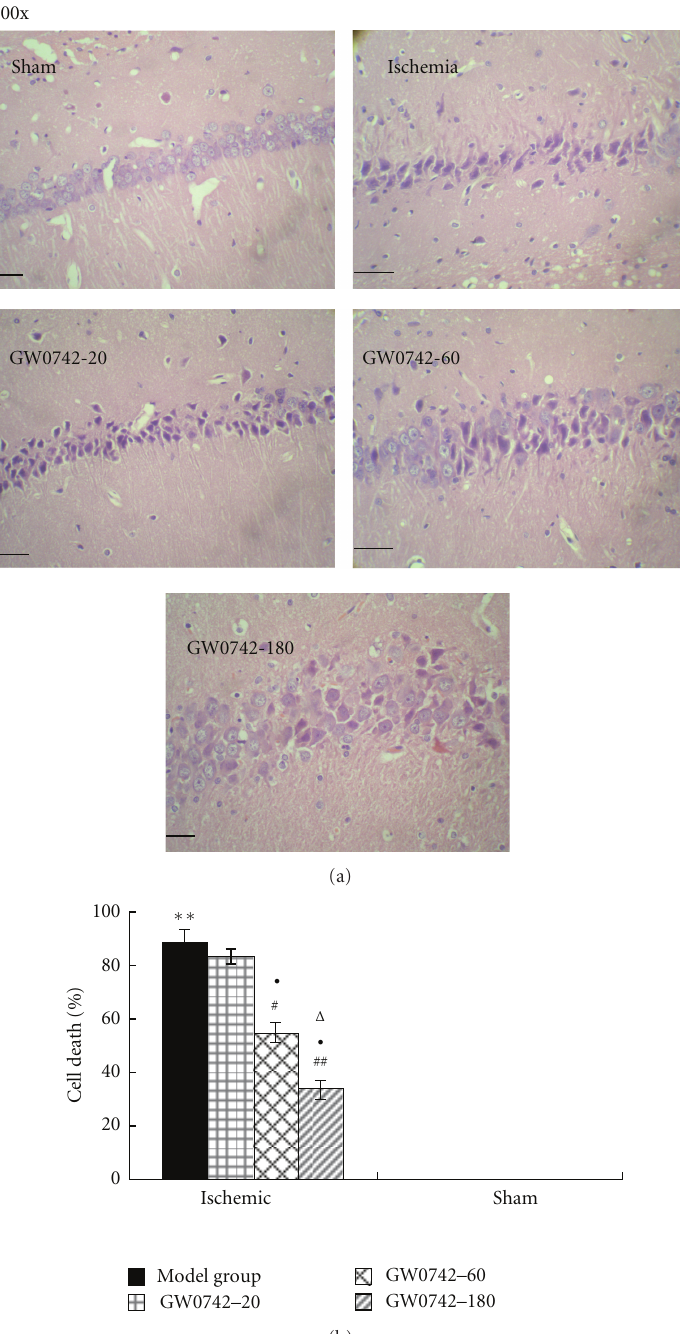
Figure 1: PPAR- β agonist GW0742 improves the global cerebral IRI-induced cytomorphological change in the hippocampus. (a) Representative pictures of H&E stained CA1 sections on day 12 post-GCIRI shown at 400x magnification. Scale bars = 50 μ m. (b) Group data showing the e ff ect of GW0742 on the cell death rate. ∗∗ P < 0 . 01 compared with vehicle sham group; # P < 0 . 05, ## P < 0 . 01 compared with the vehicle model group; Δ P < 0 . 05 compared with GW0742 20 model group; • P < 0 . 05 compared with GW0742 60 model group, ( n =